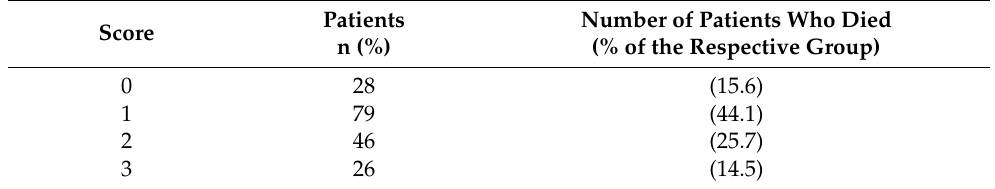
Table 3. Discrimination of 179 patients based on the number of the positive predictive factors during their first seven postoperative days.